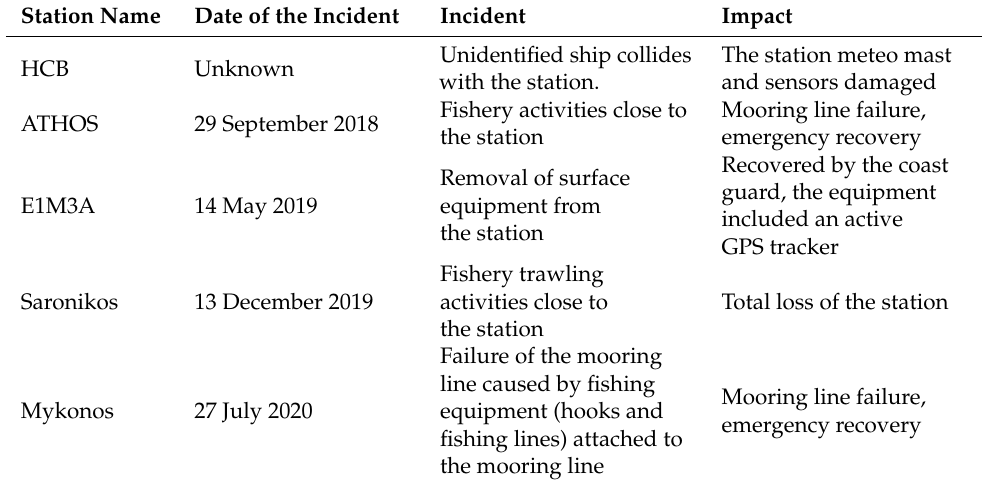
Table 5. Incidents of vandalism in the POSEIDON